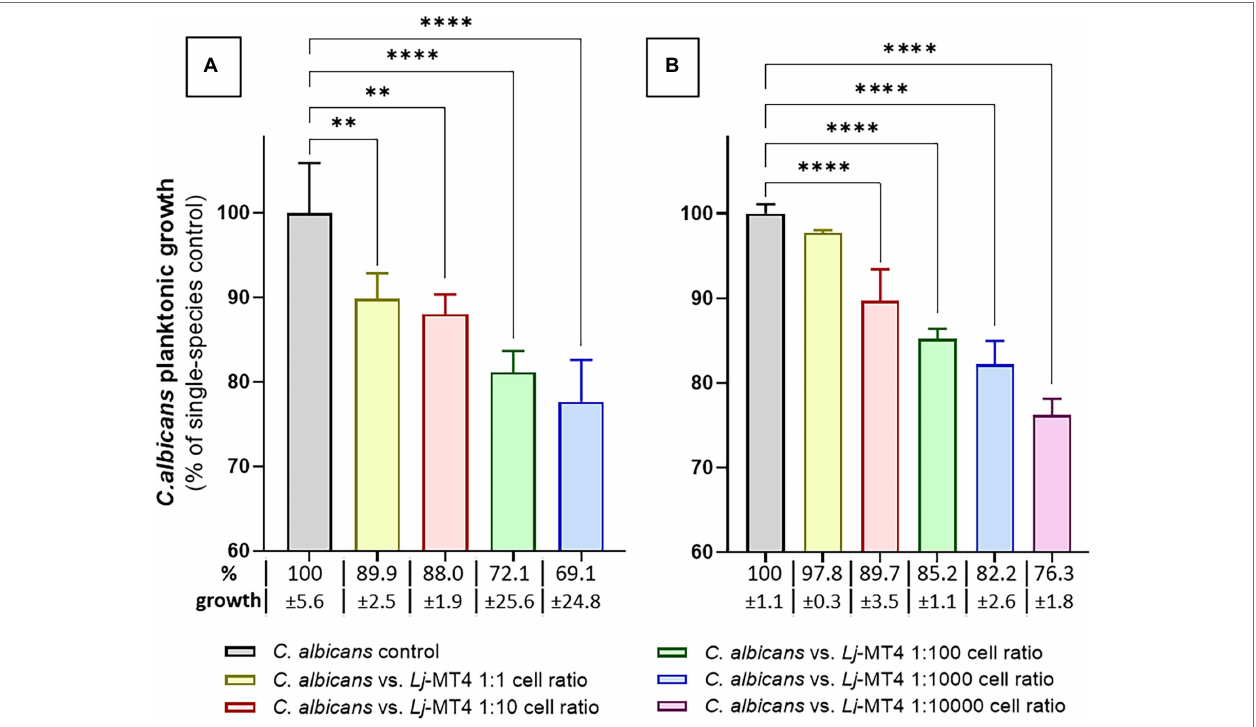
FIGURE 4 | Lactobacillus johnsonii inhibits C. albicans planktonic growth. The effect of L. johnsonii MT4 (Lj) on the planktonic growth of C. albicans (Ca) was assessed in two different growth media. L. johnsonii at different starting concentrations-inhibited C. albicans planktonic growth in a dose–response pattern. (A) MRS broth, and (B) BHI broth. Candida albicans growth inhibition is higher on MRS. One-Way ANOVA, Dunnett posttest, ** p ≤ 0.01 and **** p ≤ 0.0001. In all dual-species cultures, MRS was acidified to pH ~3.9 and BHI to pH ~5.5. 100% growth corresponds to 8.16 ± 0.41 SD and 7.47 ± 0.08 SD yeast cells ml − 1 (average, log10 values) in MRS and BHI broth,